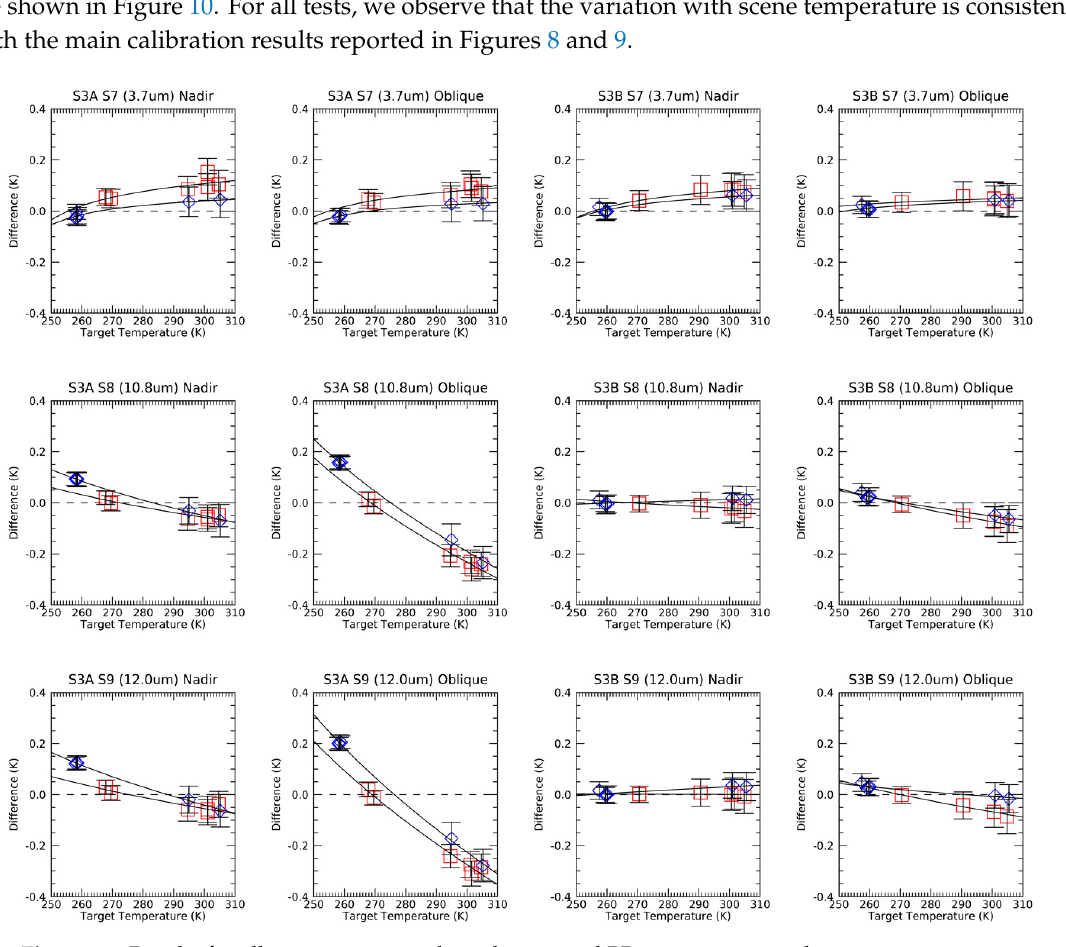
correspond to the (cid:51)